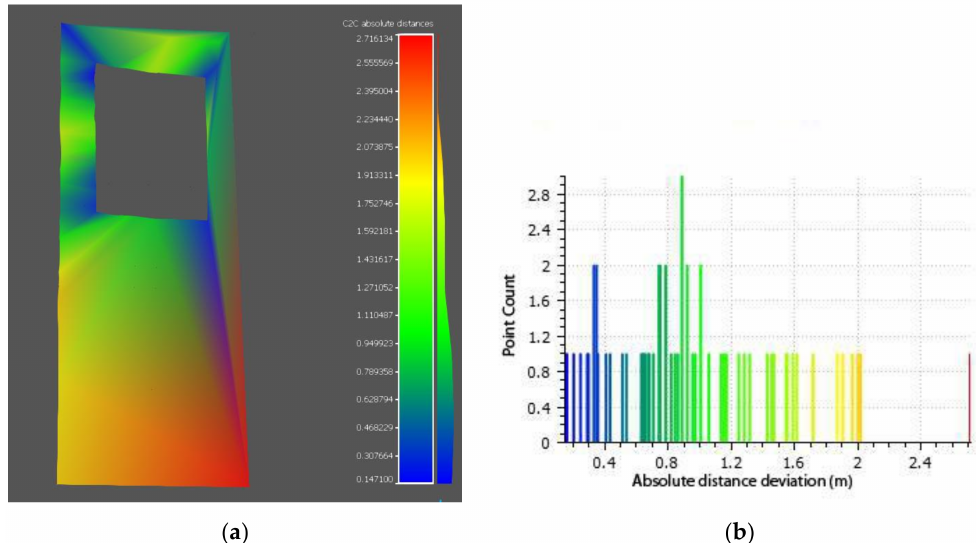
Figure 15. Accuracy assessment of the campus building: ( a ) color scalar field of the model depicting the significant deviations from the reference data; and ( b ) the corresponding histogram. The prevailing part of the points deviates around 1 m from the